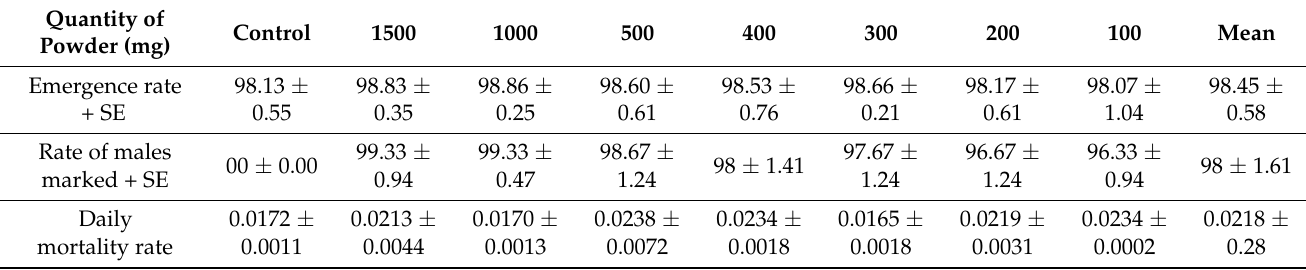
Table 1. Emergence rate and efficacy of the self-marking method as a function of the quantity of fluorescent powder applied to surface water.